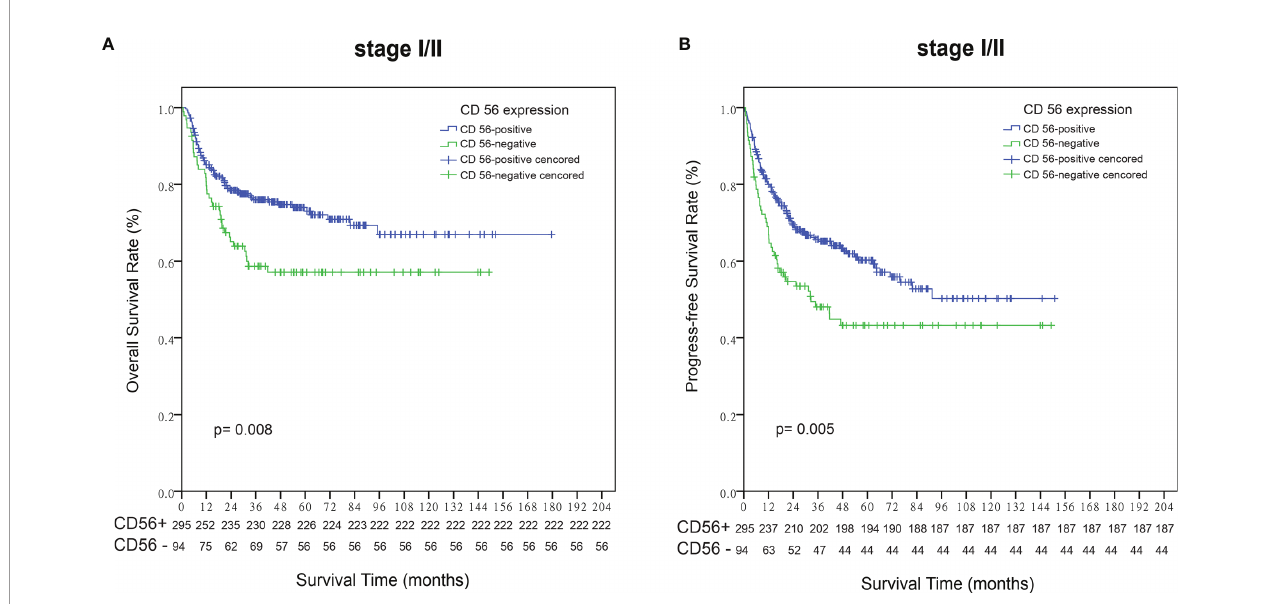
FIGURE 3 | Survival analysis according to the expression status of CD56 in patients with early stage NKTCL. (A) Overall survival (OS); (B) Progression-free survival